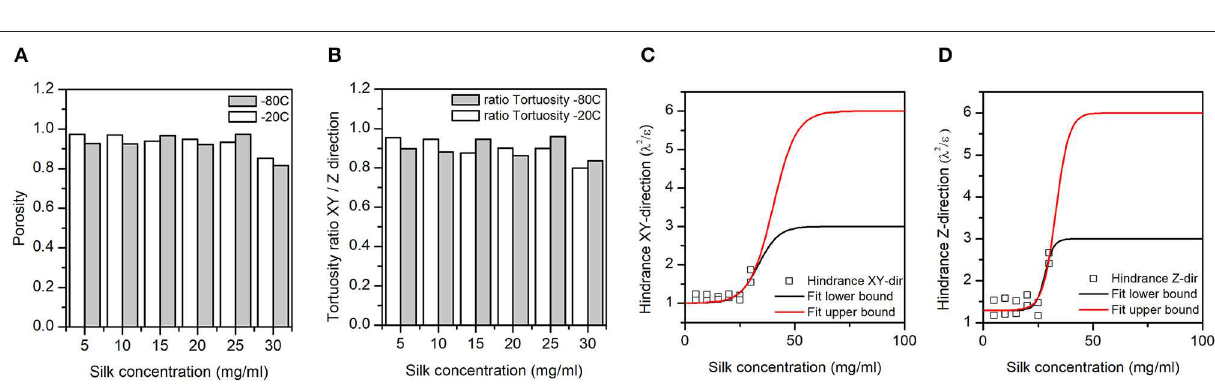
the concentration and the end freezing temperature ( Figure 6